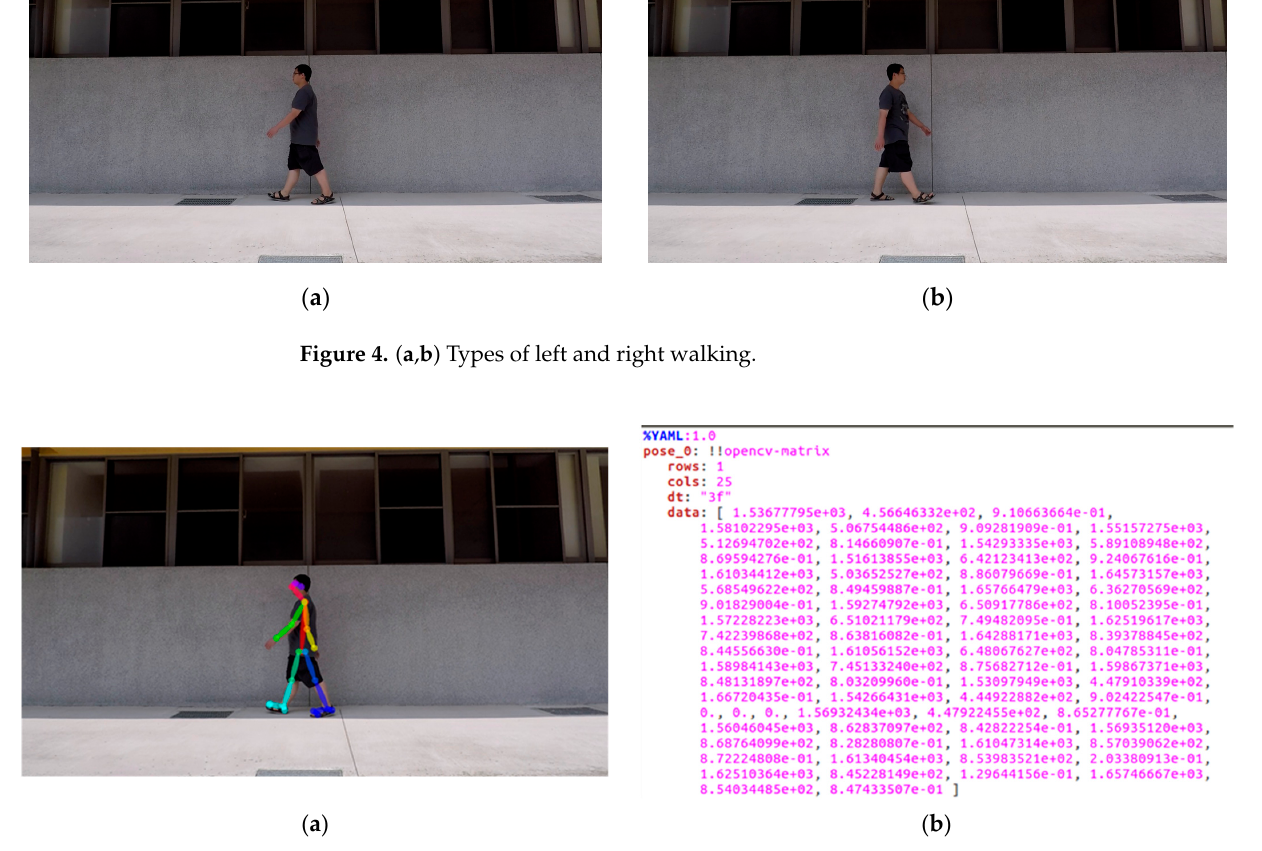
Figure 4. ( a , b ) Types of left and right walking.